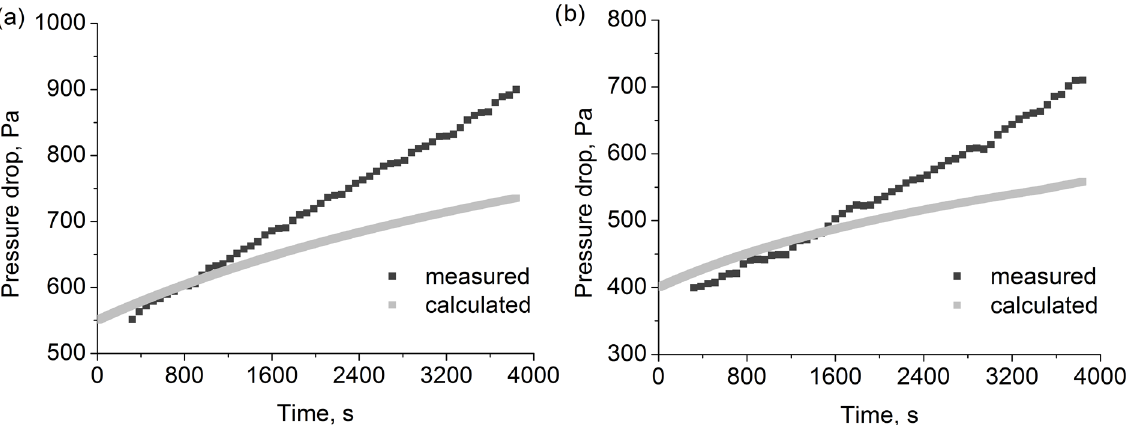
Figure 10. Pressure drop changes calculated and measured for ( a ) 2F1 and ( b ) F1 filters during oil aerosol filtration.